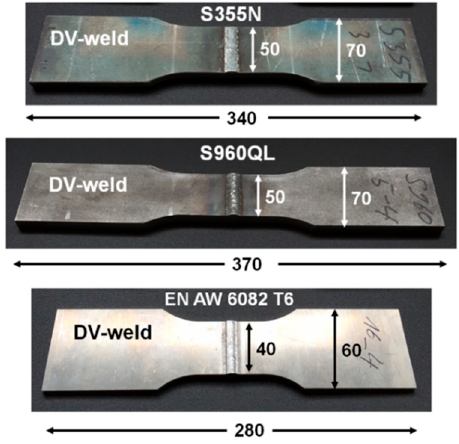
Figure 2. Fatigue test samples (DV-weld) shown in as-welded condition.